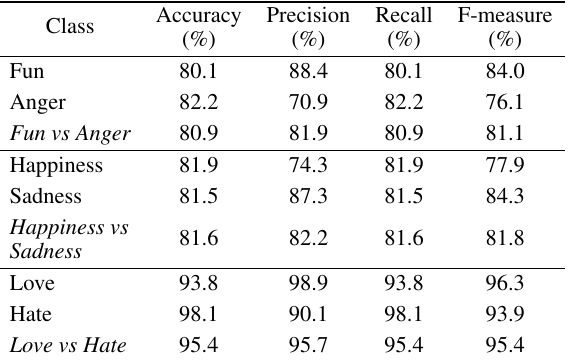
Table 2 Accuracy, Precision, Recall, and F-measure of the binary classification.